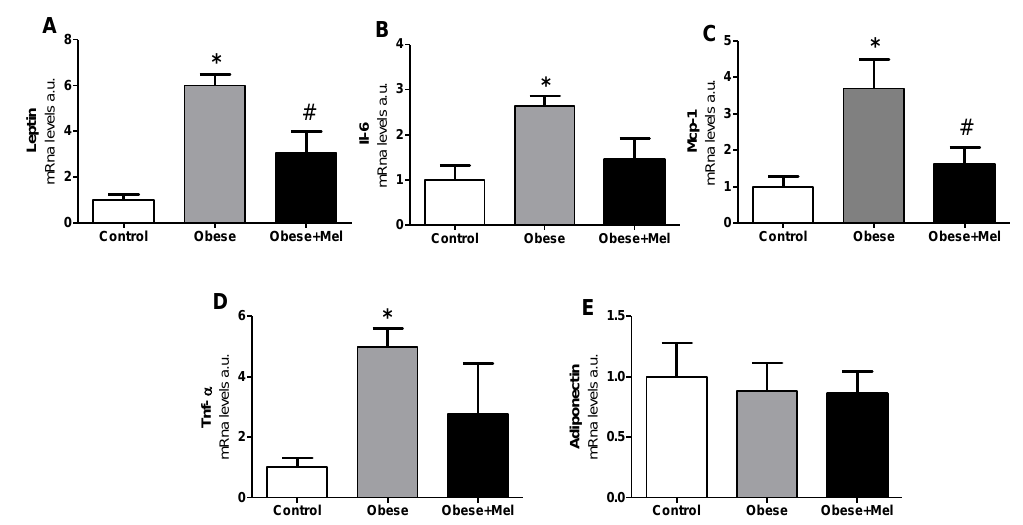
Figure 3. E ff ects of the high-fat diet (HFD) and melatonin supplementation (Mel, 1 mg / kg b.w., diluted in drinking water, daily, for 10 weeks) on mRNA levels of genes related to inflammation in epididymal (EPI) WAT from mice. ( A ) mRNA levels of Lep ; ( B ) mRNA levels of Il-6 ; ( C ) mRNA levels of Mcp-1 ; ( D ) mRNA levels of Tnf- α ; ( E ) mRNA levels of Adipoq . Results were analyzed by a one-way ANOVA and a Tukey post-test. Values are mean ± SEM (Control n = 9; Obese n = 8; Obese + Mel n = 10). * p < 0.05 vs. Control; # p < 0.05 vs. Obese .